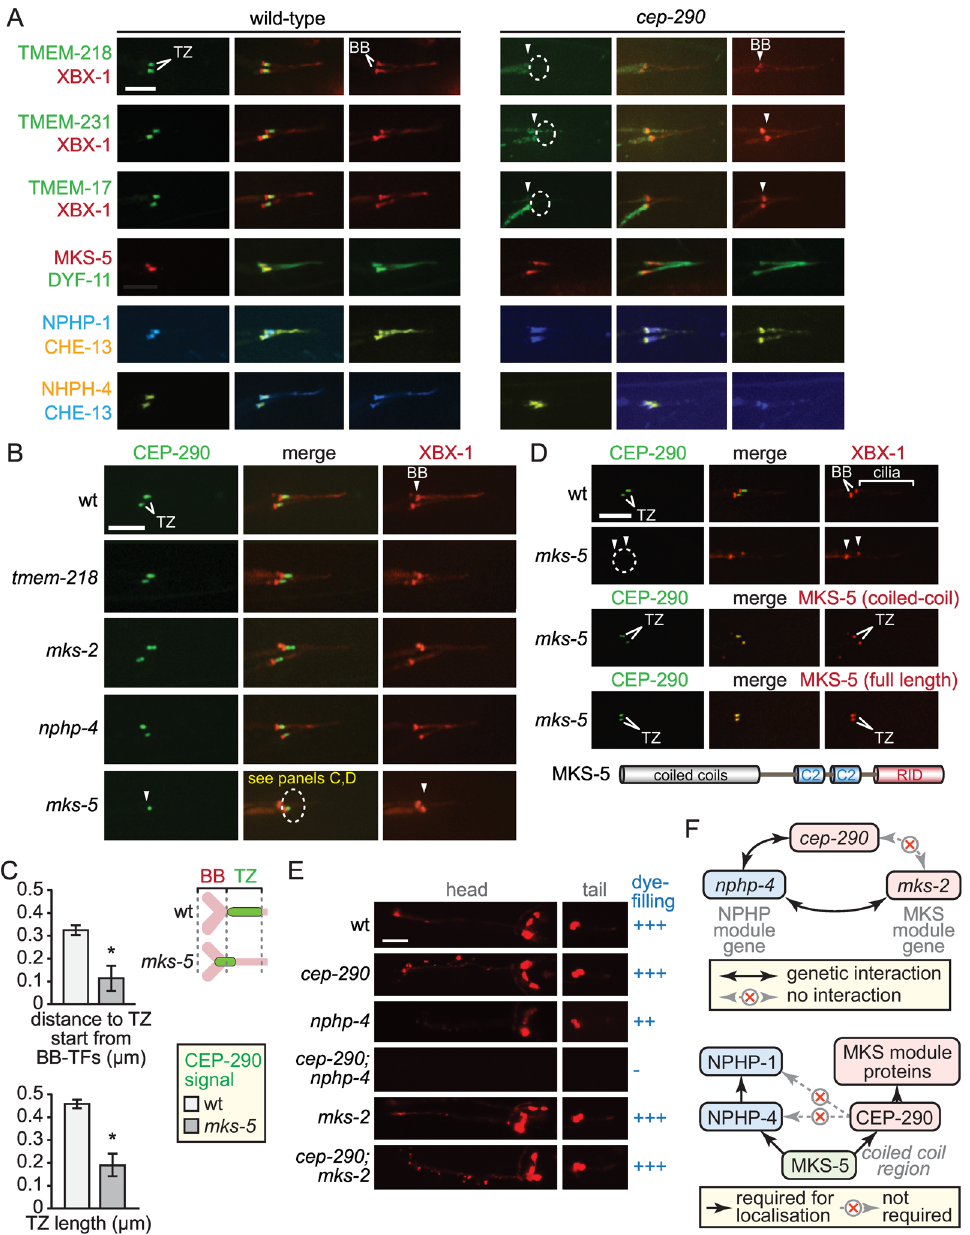
Fig 4. CEP-290 is specifically required for the assembly of the MKS module but not NPHP module components, and depends on MKS-5 for its own TZ localisation. ( A ) TMEM-218::GFP and other MKS module components (TMEM-231::GFP, TMEM-17::GFP) no longer localise to the TZ in the cep-290 mutant (dotted ellipses). However, MKS-5::tdTomato and NPHP module proteins (NPHP-1::CFP, NPHP-4::YFP) retain their localisation at the base of cilia (in the same region as the TZ) in the cep-290 mutant. Scale bars (panels A and B ), 4 μ m. ( B ) Transition zone localisation of GFP-tagged CEP-290 (green) requires MKS-5 (dotted ellipse) but is not affected by loss of MKS or NPHP module components. XBX-1::tdTomato (red) marks the basal body-transition fibres and axoneme. CEP-290 levels are reduced in the mks-5 mutant, and remaining signals are closer to the basal body-transition fibres (see panel C; panel D shows complete loss of CEP-290 in the mks-5 mutant). ( C ) Analysis of CEP-290 localisation in wild-type and mks-5 mutant. Quantitation of CEP- 290::GFP signal in the mks-5 mutant reveals closer localisation to the basal body-transition fibre region (marked by XBX-1::tdTomato) and reduced signal length compared to that of wild-type animals. * , Fisher ’ s exact test for significance, p < 0.05. Schematic depicts differences in wild-type and mks-5 mutant CEP-290::GFP localisation patterns. BB, basal body; TF, transition fibres. (D) Loss of CEP-290 TZ localisation in the mks-5 mutant (dotted ellipse) is restored through expression of full length MKS-5, as well as the coiled coil domain of MKS-5 alone (refer to schematic for MKS-5 domain structure; RID, RPGR- interacting domain). XBX-1 is used to mark the basal body-transition fibres and axoneme. Scale bar, 4 μ m. ( E ) Dye-filling assays, which probe for intact ciliary structures, reveal a genetic (synthetic) interaction between cep-290 and an NPHP module mutant ( nphp-4 ; dye-filling lost, shown as “ - ” ) but not an MKS module mutant ( mks-2 ; dye-filling normal, “ +++ ” ). Scale bar, 40 μ m. ( F ) Schematics showing cep-290 genetic interaction with nphp-4 but not mks-2 (top),